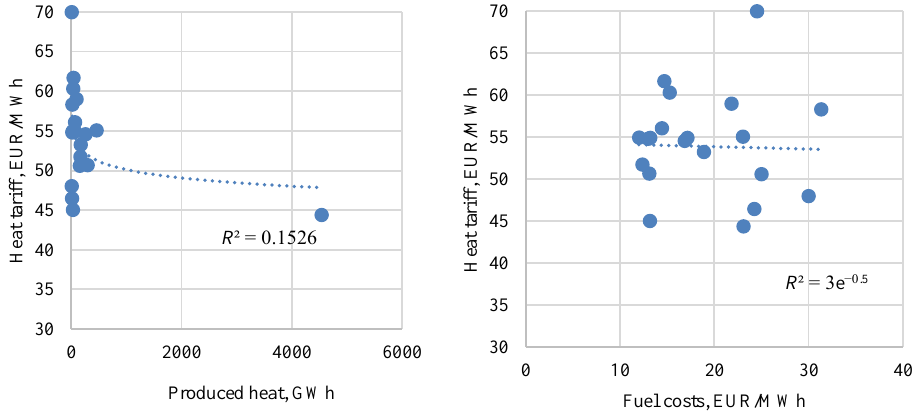
Fig. 5. Regression analyses results for different